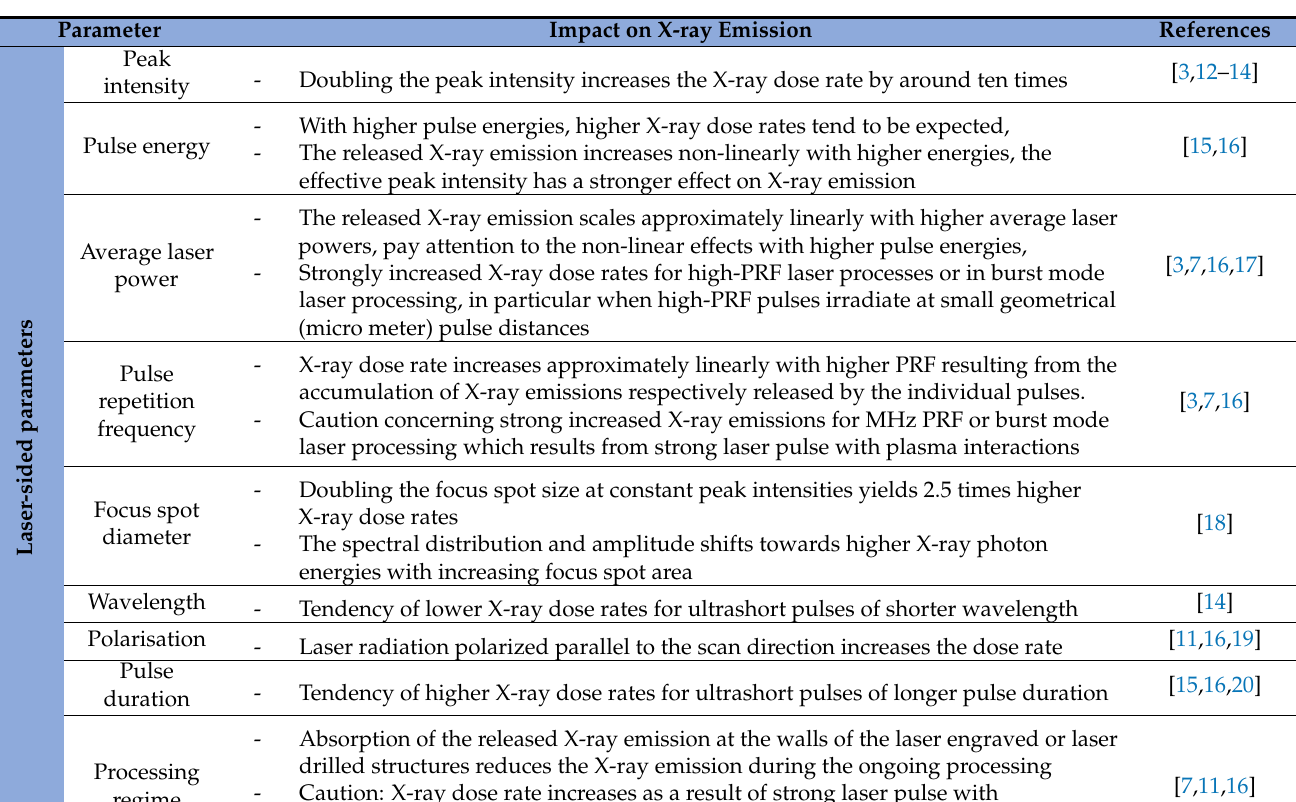
Table 1. A summary of the influencing factors affecting X-ray photon emissions arising from ultra- short pulse laser materials